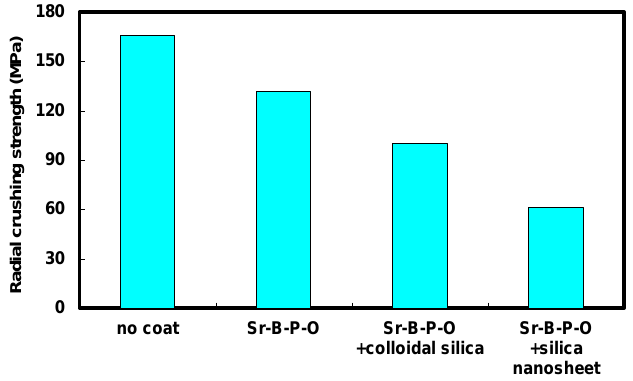
Figure 9. Radial crushing strengths of annealed toroidal cores fabricated from uncoated iron powder particles, particles with only Sr-B-P-O insulating layers, and particles with five coatings of colloidal silica or silica nanosheets over Sr-B-P-O insulating layers.